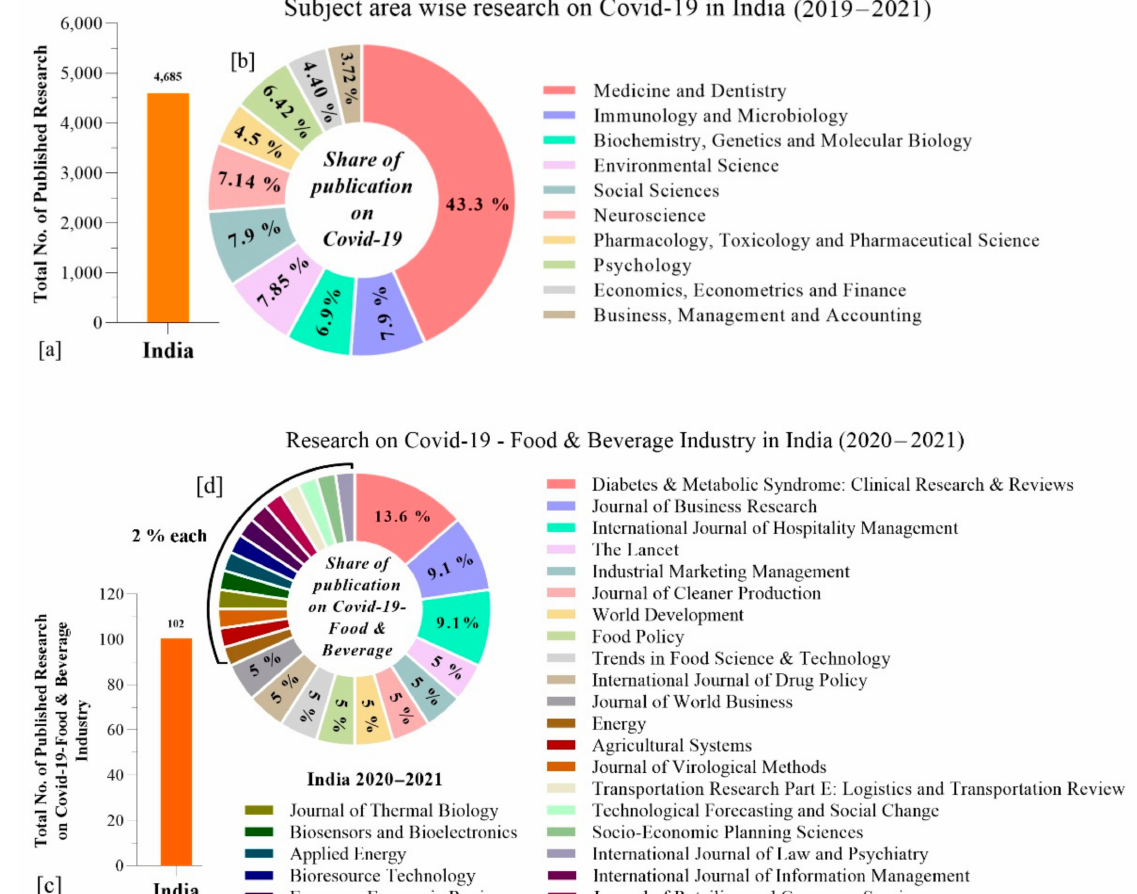
Figure 3. ( a ) Total number of published research studies on COVID-19; ( b ) subject area specific research on COVID-19